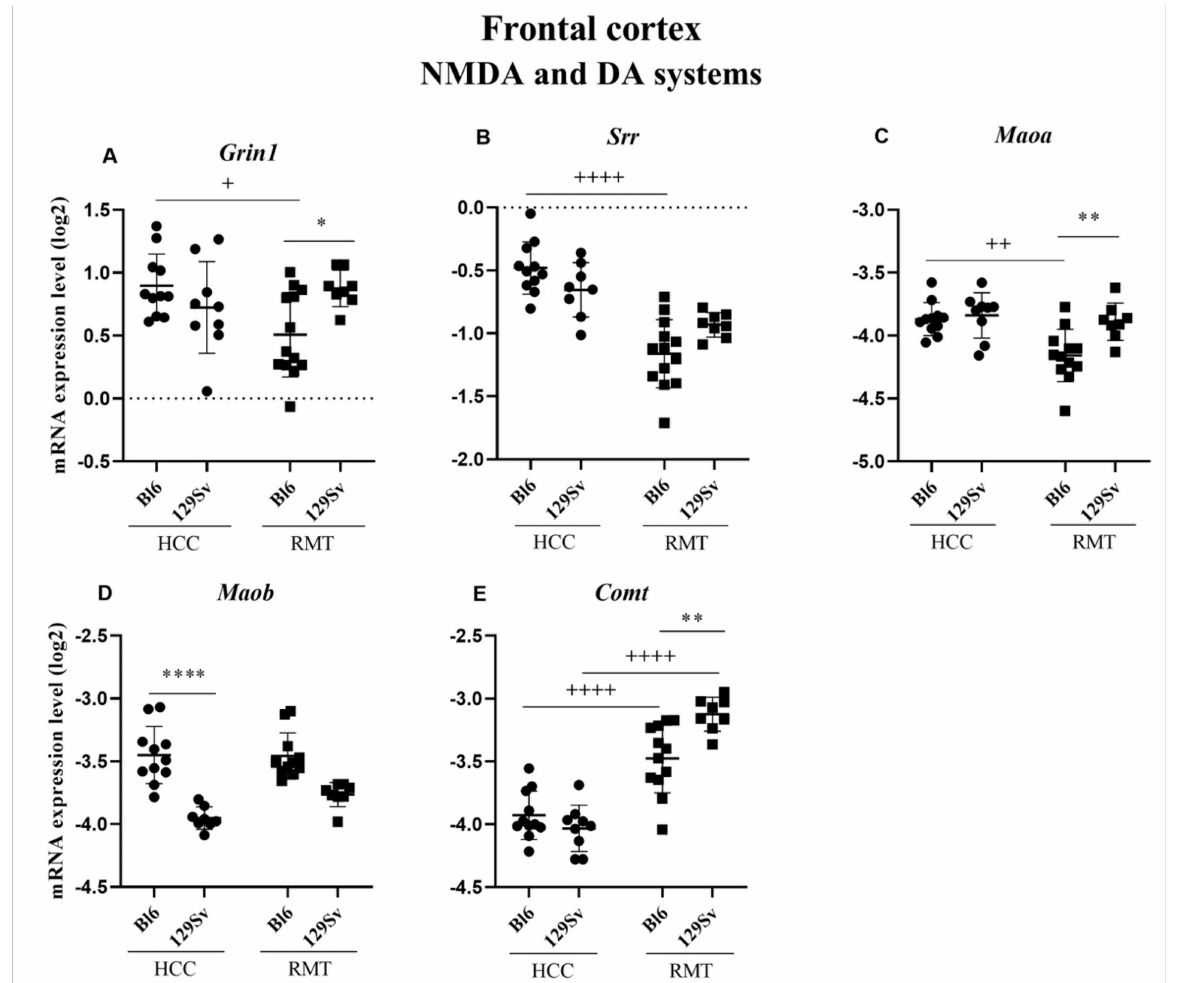
Figure 6. NMDA and DA systems gene expression in the frontal cortex of Bl6 and 129Sv mice. Two-way ANOVA was applied to demonstrate differences between the strains and environments. Substantial statistically significant gene expressions for ( A ) Grin1 —glutamate ionotropic receptor NMDA type subunit 1, ( B ) Srr —serine racemase, ( C ) Maoa —monoamine oxidase A, ( D ) Maob —monoamine oxidase B and ( E ) Comt —catechol-O- methyltransferase. Bonferroni post hoc test: * p ≤ 0.05, ** p ≤ 0.01 and **** p ≤ 0.0001 compared to respective 129Sv mice; + p ≤ 0.05, ++ p ≤ 0.01 and ++++ p ≤ 0.0001 in strain specific comparison. Data are expressed as mean values ± SD. Number of animals in each group varied from 8 to